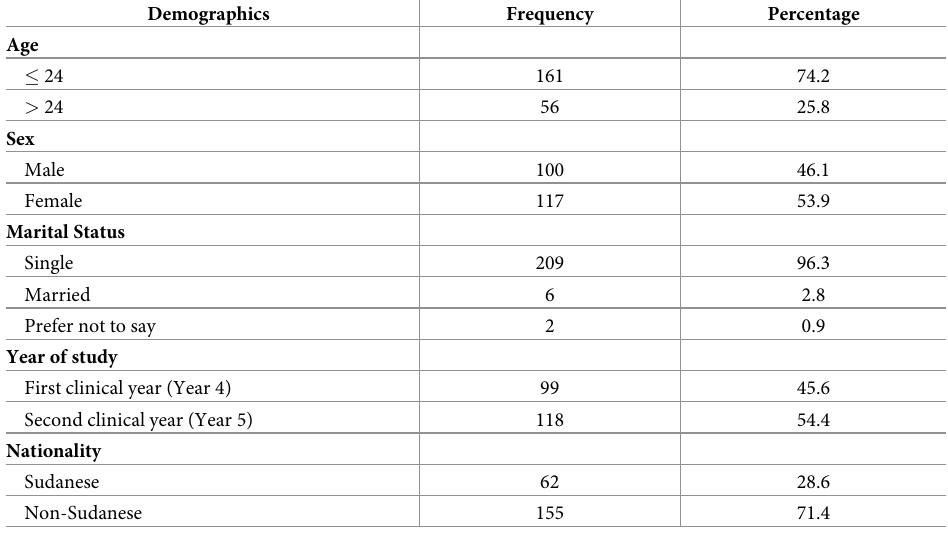
Table 1. Demographic characteristics of medical students at IUA, Khartoum, Sudan, 2021 (n =